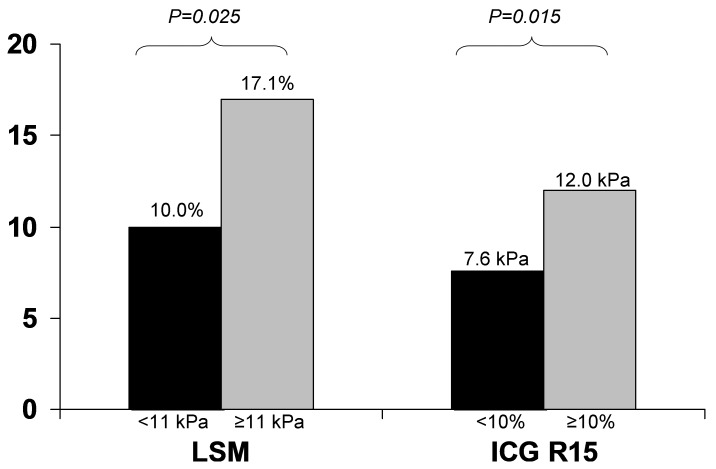
Comparison between LSM and ICG R15.